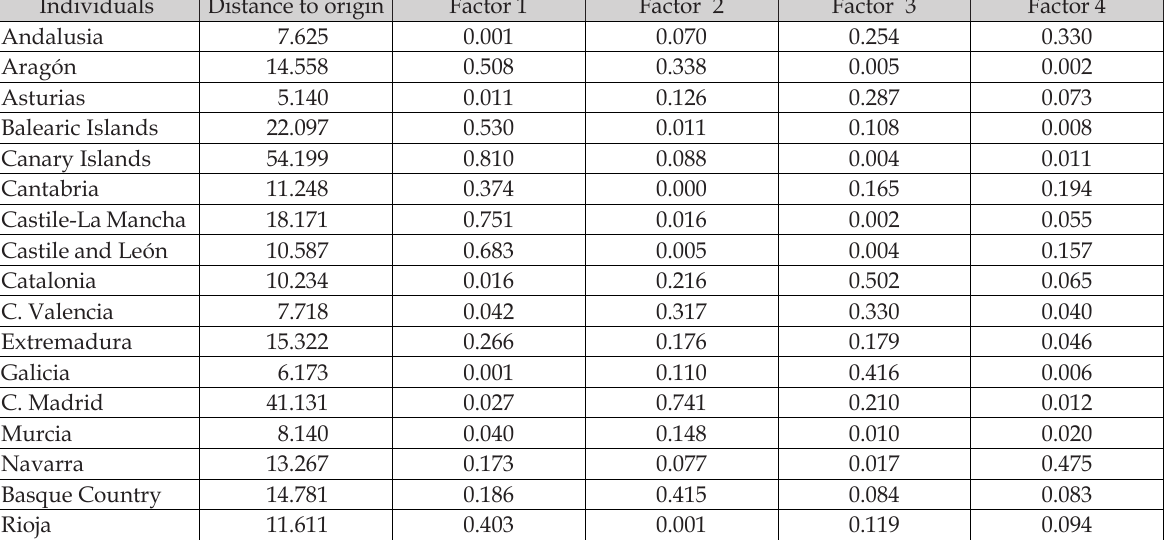
Table 3. Complete table of relative contributions.